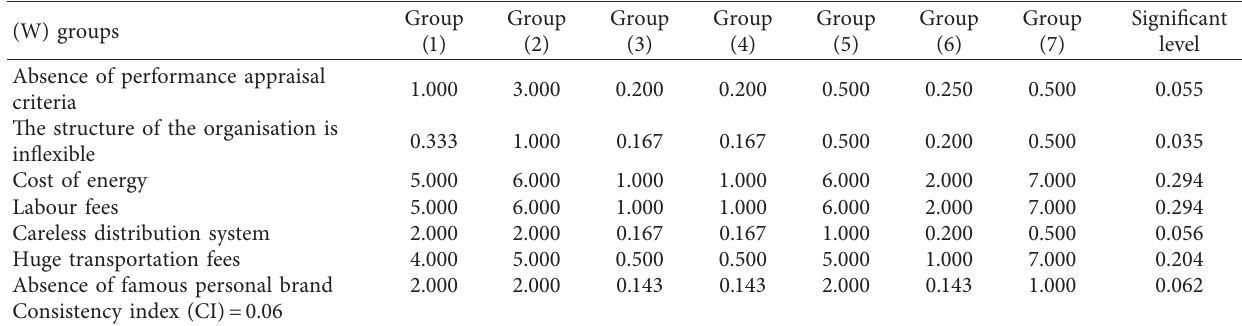
Table 6: Analogy matrix of (W) group.